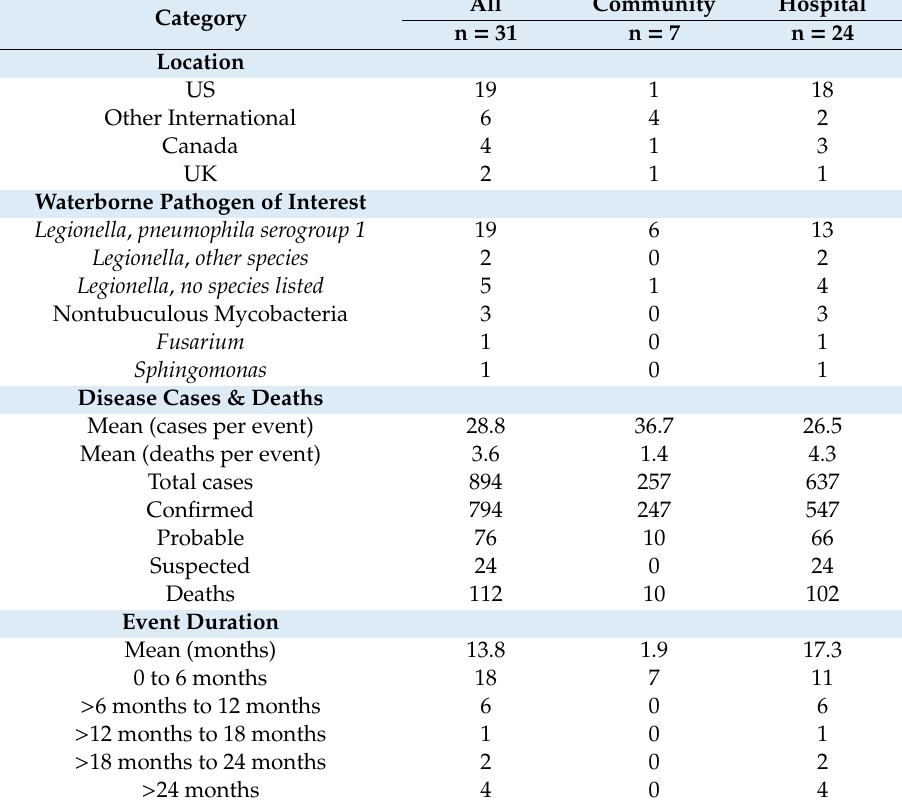
Table 2. Event characteristics.